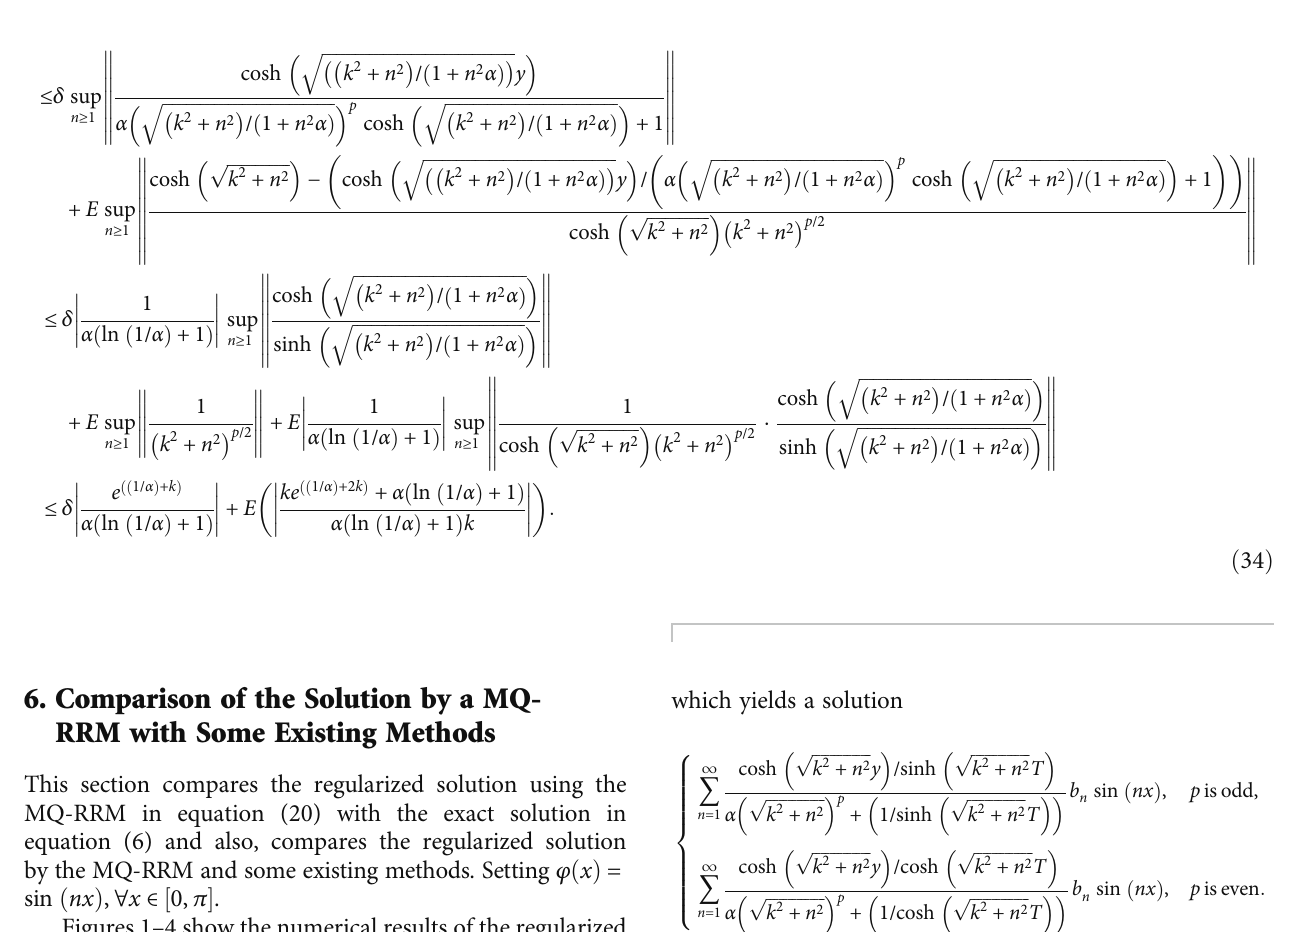
p k 2 + n 2 p k 2 + n 2